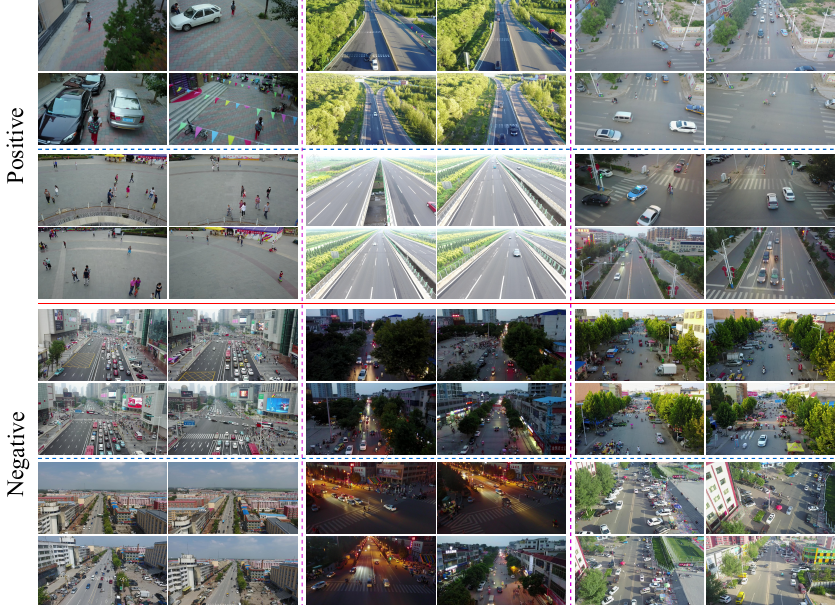
Figure 6. Visualization of positive and negative image samples classified by our Dynamic Gate in the DyCC-Net. Positive image samples in the top two rows are processed with the Light Path and negative image samples in the bottom two rows are processed with the Heavy Path.